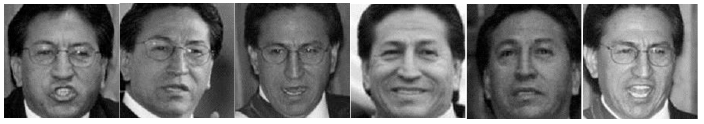
Figure 7. Some samples of one person on the LFW database.